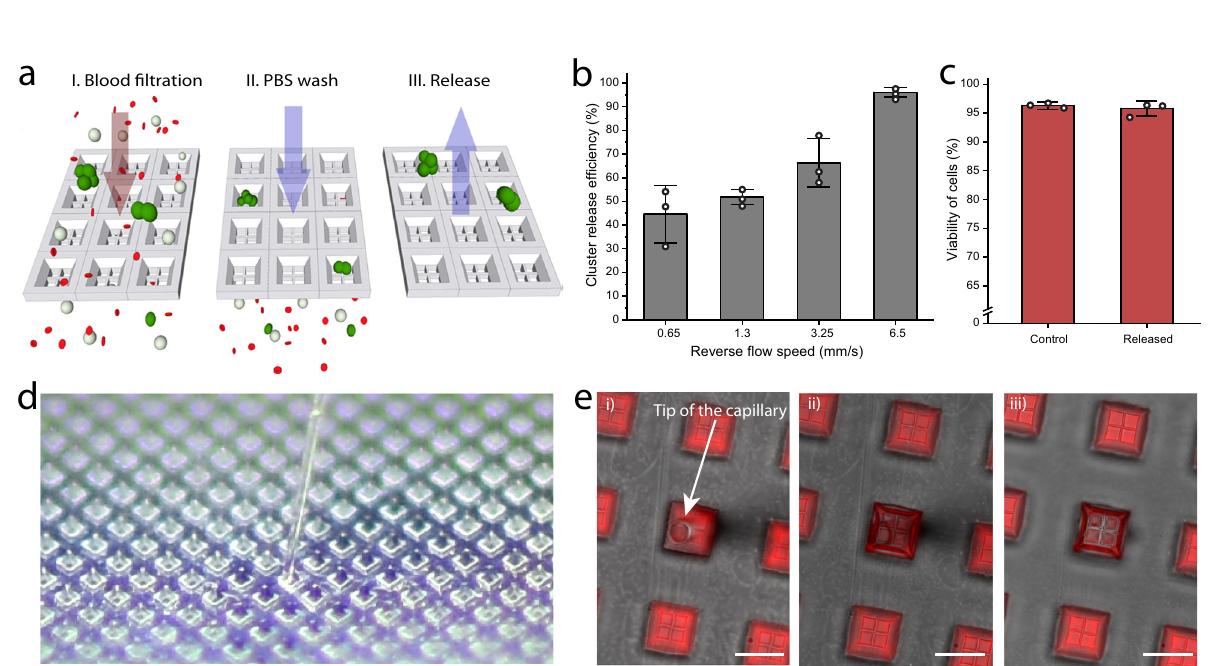
Fig. 3 Retrieval of captured clusters from the Cluster-Wells. a Representation of the release process. LNCaP clusters were spiked into whole blood and processed using Cluster-Wells. Following the PBS wash, captured clusters were released into a Petri dish by the application of reverse fl ow. b Release ef fi ciency of the device at different relative reverse fl ow speeds. Following the release, both Petri dish and device were imaged using a fl uorescence microscope, and the cells were counted manually for the calculation of release ef fi ciency ( n = 3 independent experiments). Data are presented as mean ± SD. c Percentage viability of control and clusters released into a Petri dish at 6.5 mm/s reverse fl ow speed ( n = 3 independent experiments). The two-color viability test was performed on the control and released cells inside the Petri dishes (see “ Methods ” : measurement of the cell viability), which were subsequently scanned using fl uorescence microscope. The number of viable and dead cells were counted for calculating the percentage of viable cells. Data are presented as mean ± SD. d A photo of the Cluster-Wells and the capillary of a micromanipulator inside an individual microwell. Unlike micro fl uidic devices, individual microwells could easily be accessed using a micromanipulator. e Fluorescence microscope images of the Cluster-Wells after being removed from the fi lter holder. Due to surface tension, previously introduced fl uorescent dye solution stays inside the wells and the content of individual microwells can be retrieved using a micromanipulator. When left unattended, microwells dry in ~ 10 min. Scale bars, 50 μ m. Source data are provided as a Source Data fi